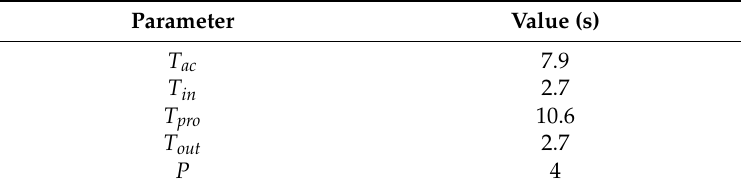
Table 8. The real-time parameters of the multi-node system.